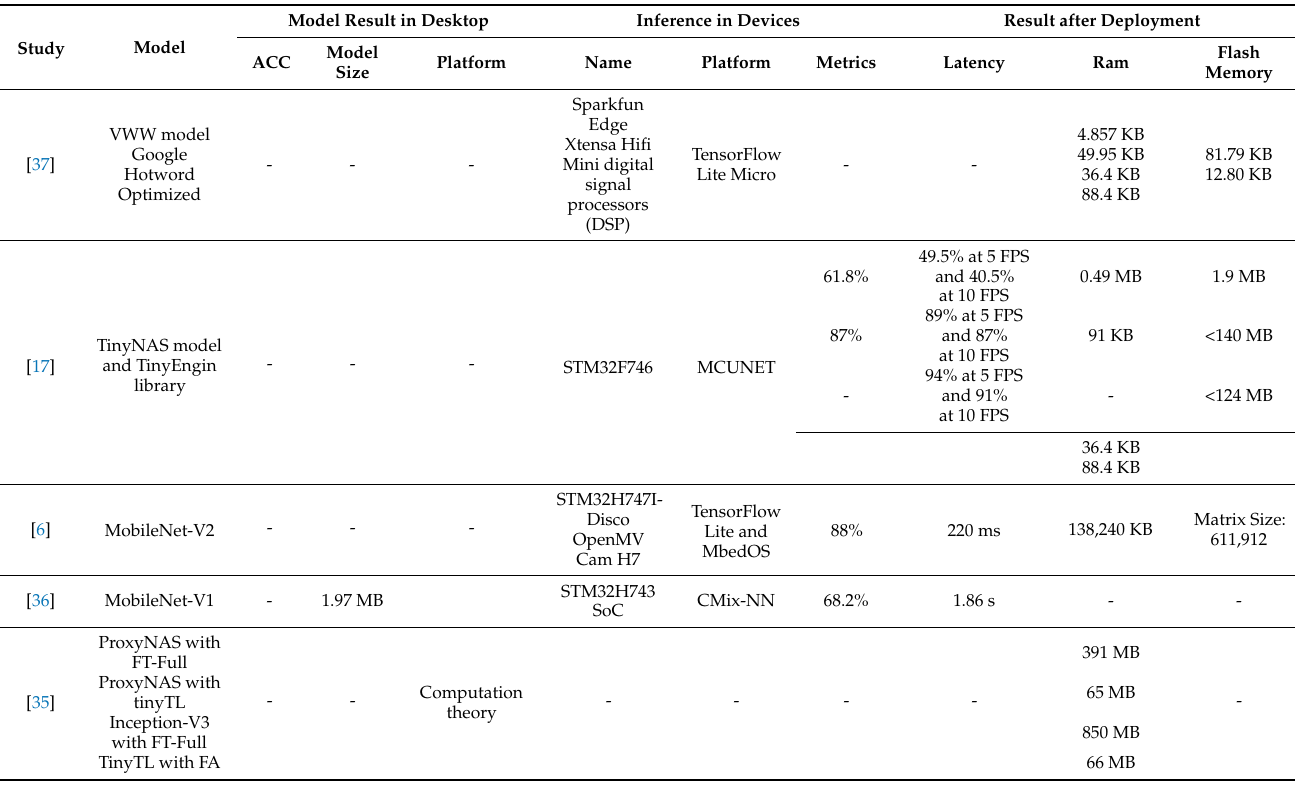
Table 3. Comparison between earlier studies related to Design tinyML frameworks and libraries based on the used models, the results and the inference